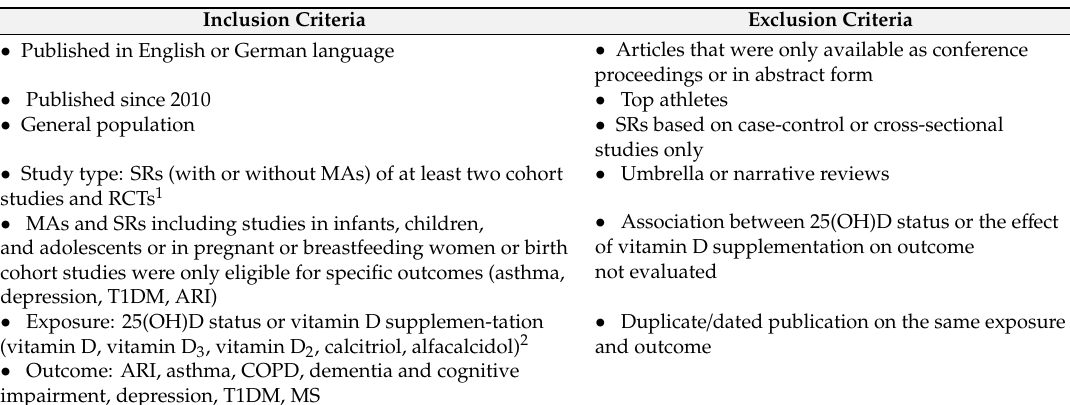
Table 1. Inclusion and exclusion